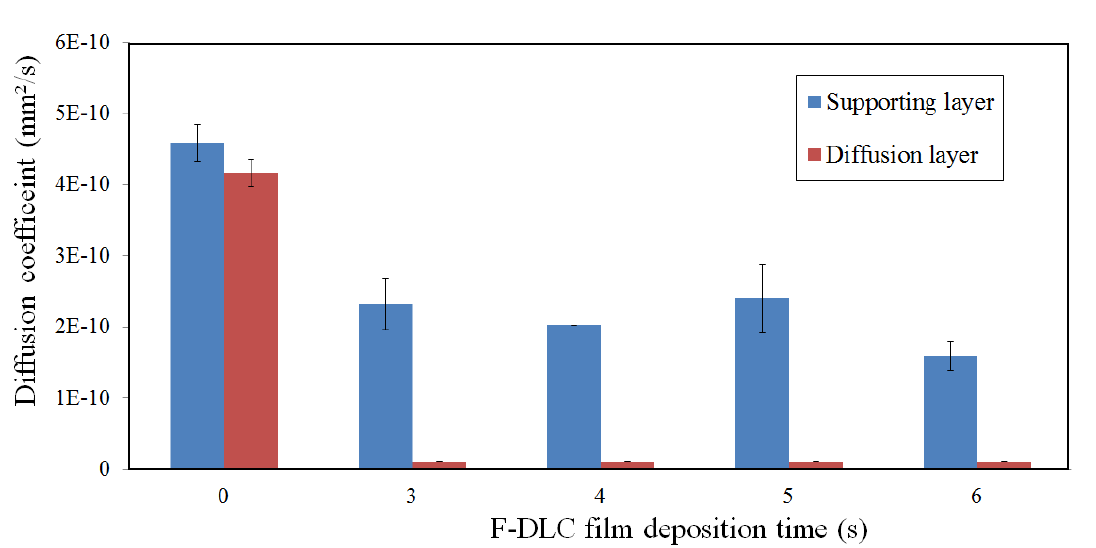
Figure 8. Diffusion coefficients of diffusion and finger like structure layer of PES membrane before and after coated by F-DLC